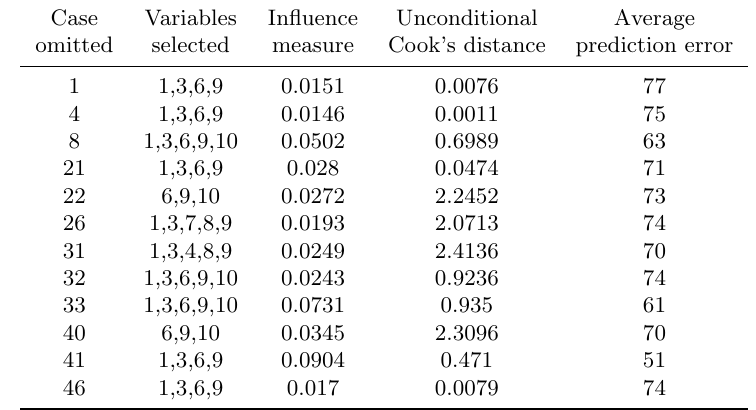
Table 4: Evaporation data: Variable selection with AIC